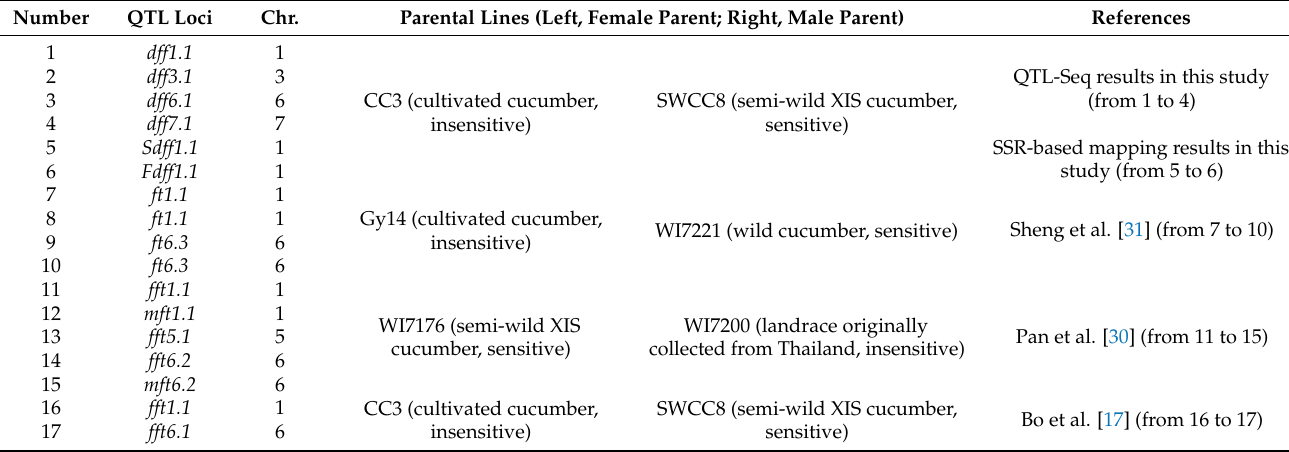
Figure 2. Summary of the mapping results on DFF. ( a ) The QTL-Seq results by the F 2 population derived from the cross of CC3 and SWCC8. ( b ) The overlapping region of DFF on chromosome 1. ( c ) The structure variation of candidate gene CsaNFYA1 ( Csa1G613580 ). The only one non-synonymous mutation was detected at 2522 (D to G, Aspartate to Glycine). Table 5. Summary of QTLs detected on the days to first